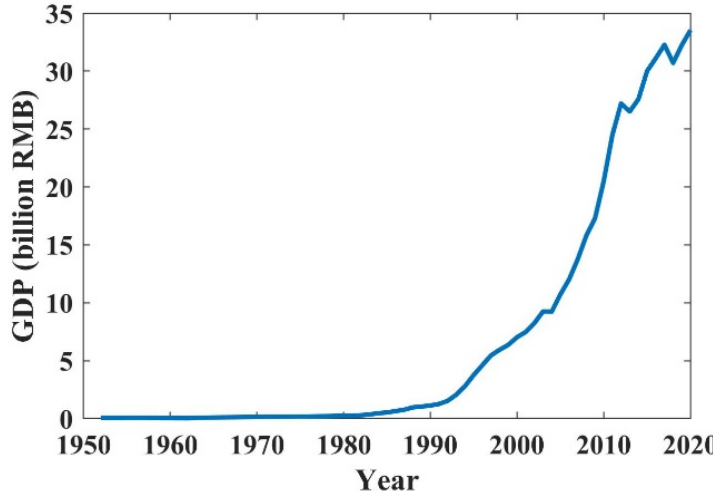
Figure 7. Change in the gross domestic product (GDP) of Baoding, Hebei Province, China, from 1952 to 2020.